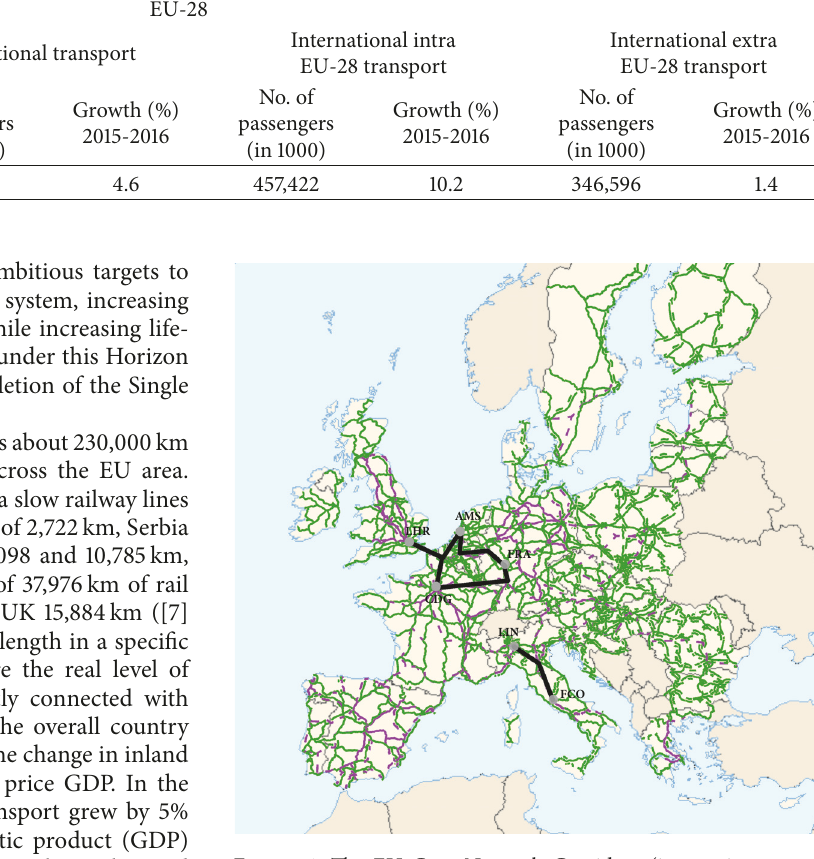
Figure 1: The EU Core Network Corridors (interactive maps at https://ec.europa.eu/transport/themes/infrastructure